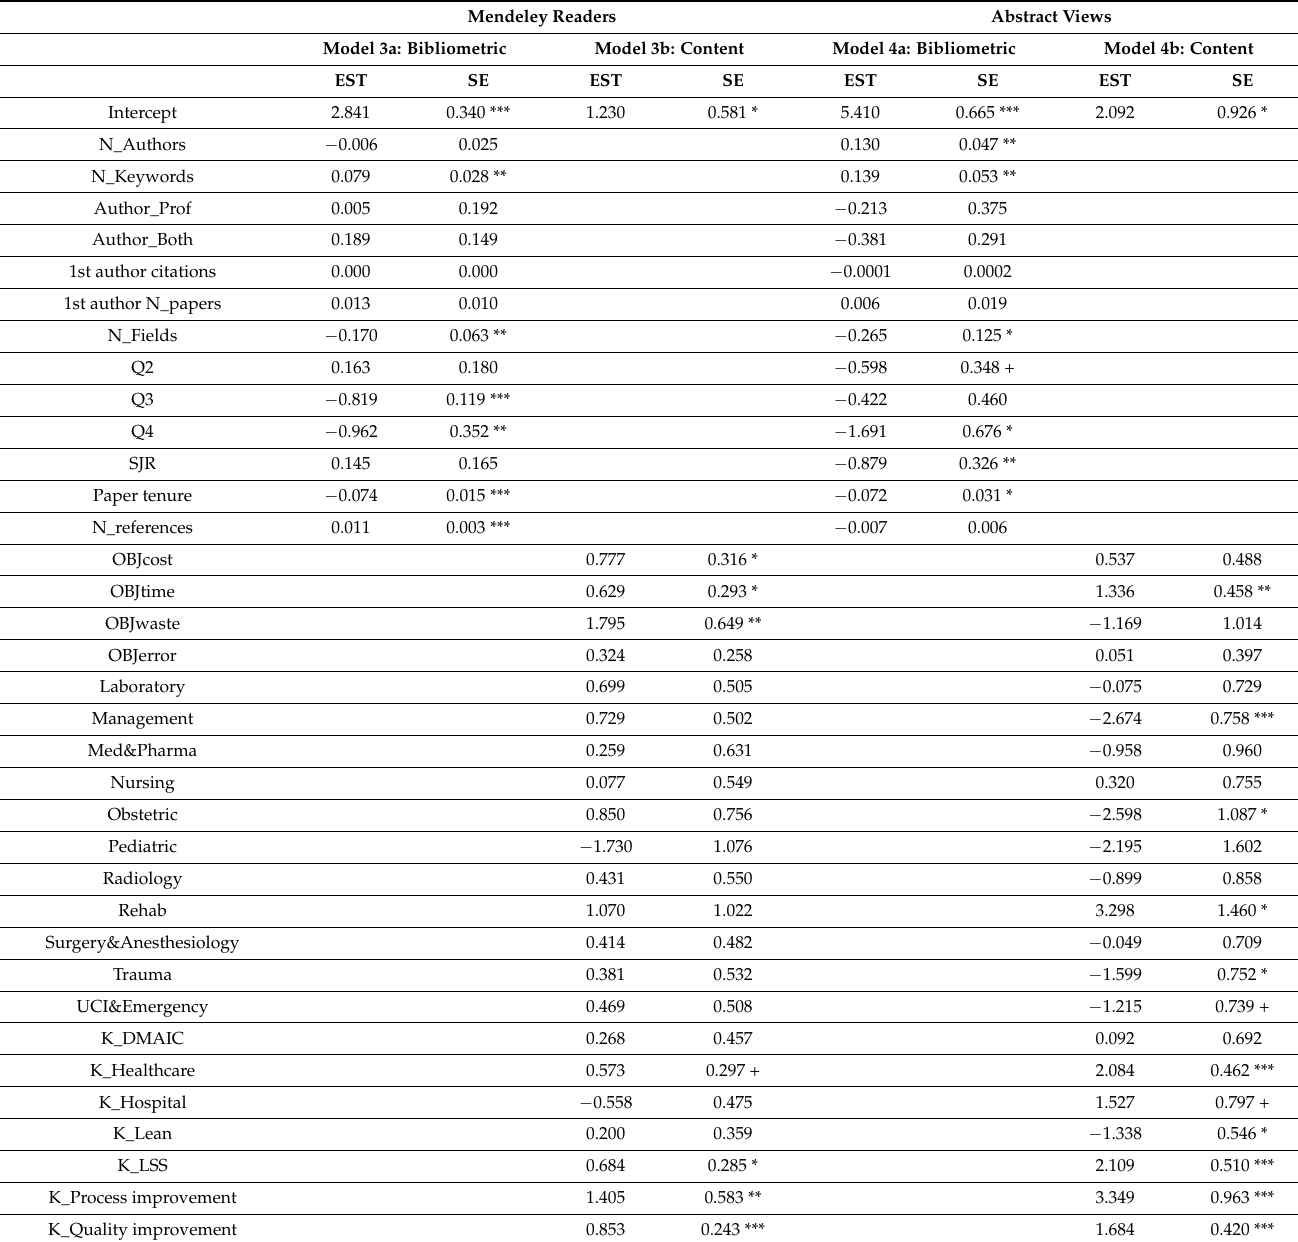
Table 3. Zero-inflated negative binomial regression model for alternative metrics of research